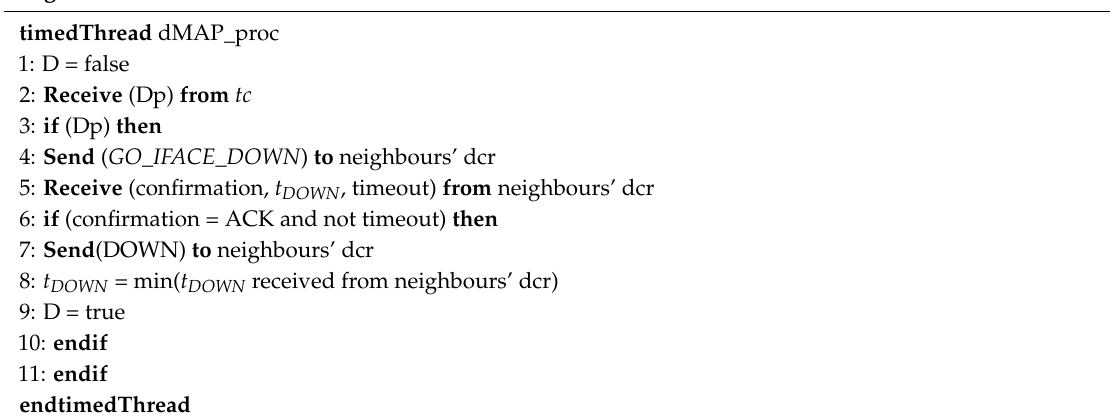
Algorithm 3: Basic Pseudocode of the dcr dMAP_Proc Process